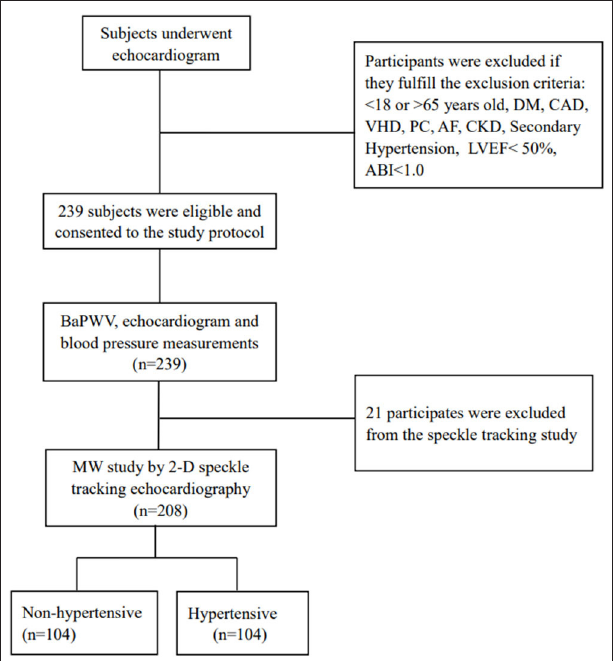
FIGURE 1 | Flow diagram for the study population. ABI, ankle-brachial index; AF, arterial fibrillation; CAD, coronary artery disease; CKD, chronic kidney disease; DM, diabetes mellitus; LVEF, left ventricular ejection fraction; MW, myocardial work; PC, primary cardiomyopathies; VHD, valvular heart disease.